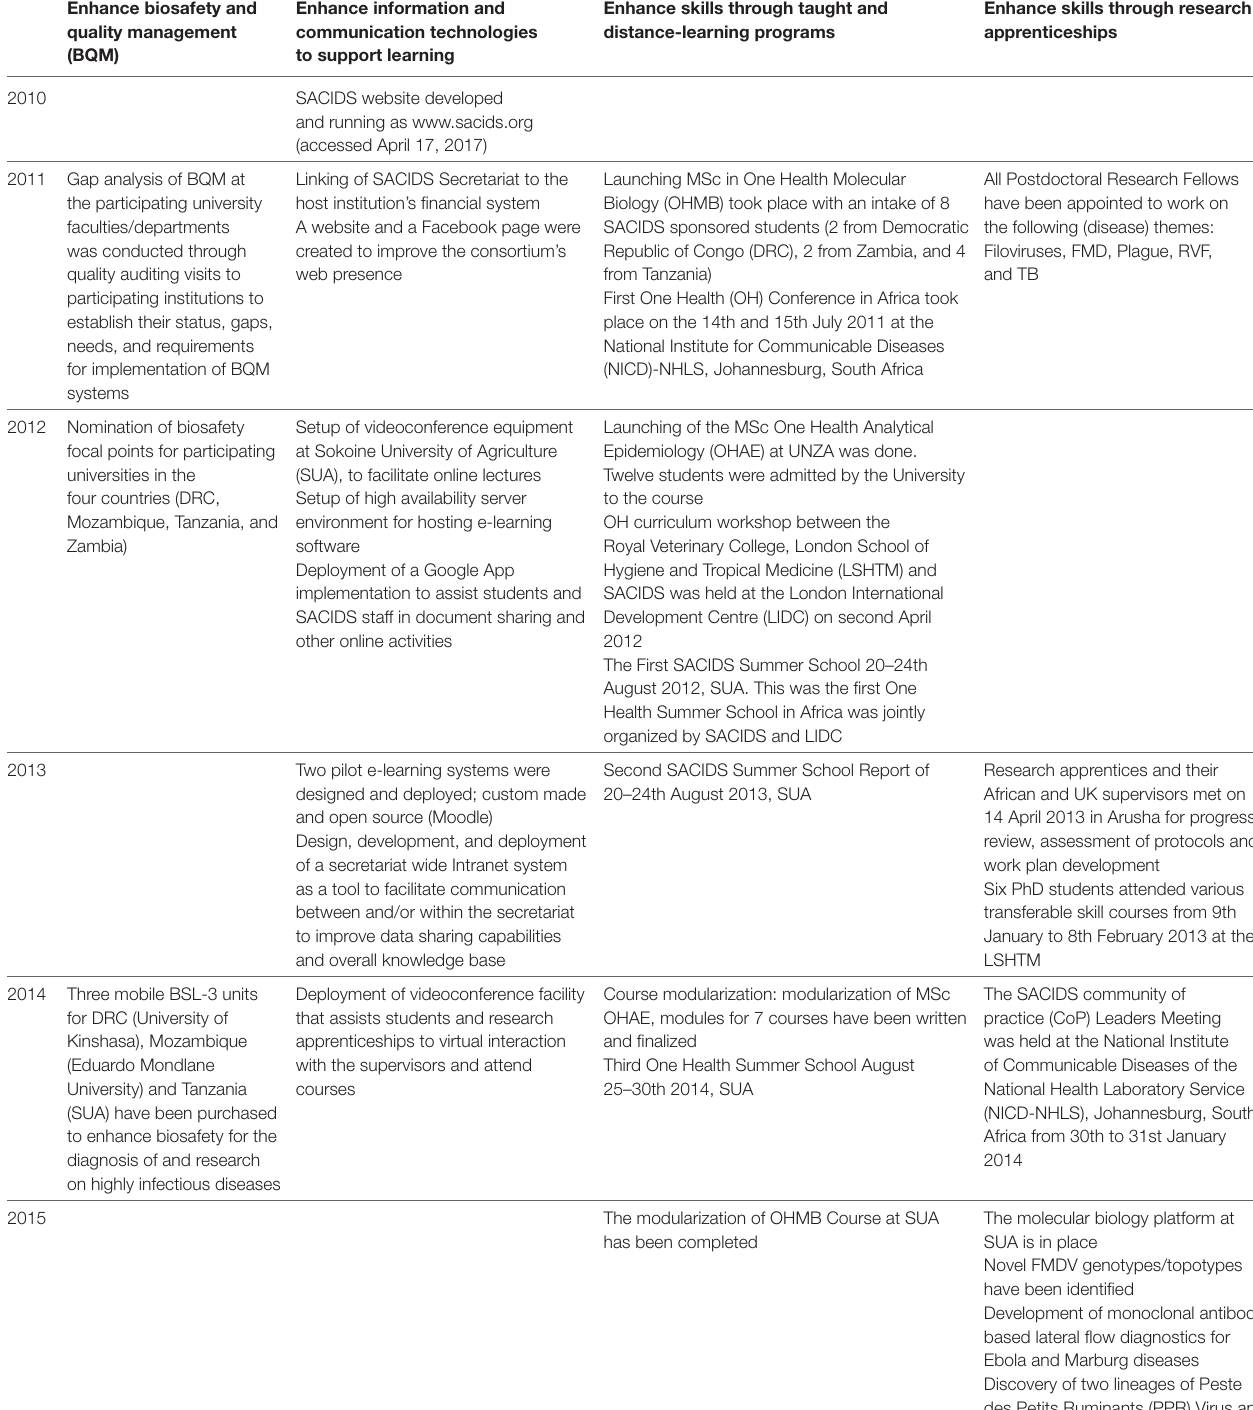
Table 1 | Southern African Centre for Infectious Disease Surveillance (SACIDS)’ outputs by objective and year. enhance biosafety and quality